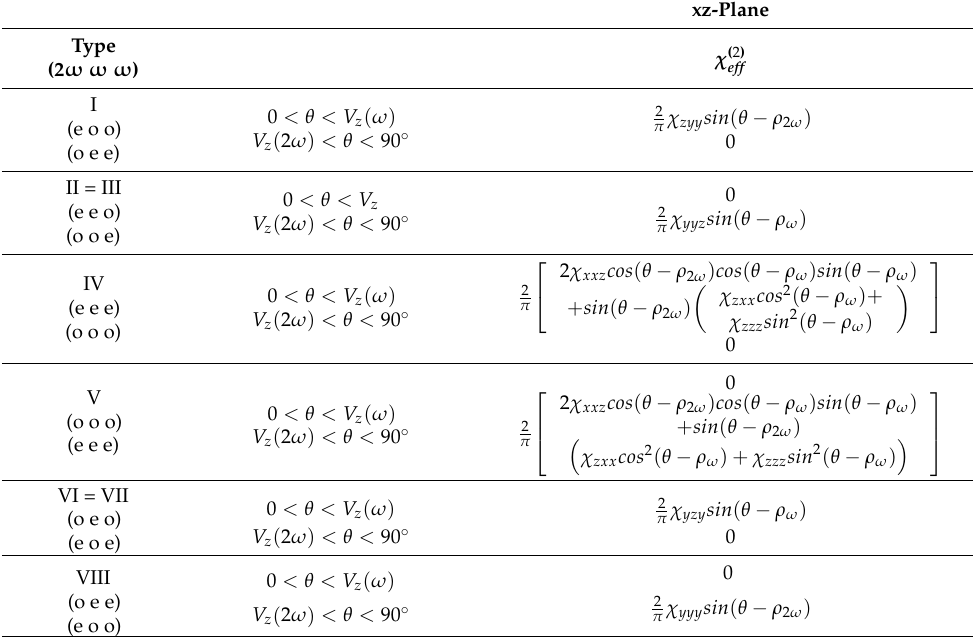
Table 4. Effective coefficient of AQPM SHG corresponding to all possible configurations of polariza- tion for AQPM SHG in the xz-plane of the crystal class mm2 and the positive biaxial optical class, which is the case of PPRKTP. The χ ijk ’s stand for the independent coefficients of the second-order electric susceptibility tensor at 2 ω . ρ ω and ρ 2 ω are the double refraction angles of the fundamental and second-harmonic waves, respectively. (o) and (e) stand for the ordinary and extraordinary polarizations, respectively. V z ( ω ) and V z ( 2 ω ) are the optical axes at ω and 2 ω , respectively, with V z ( ω ) < V z ( 2 ω ) in the case of